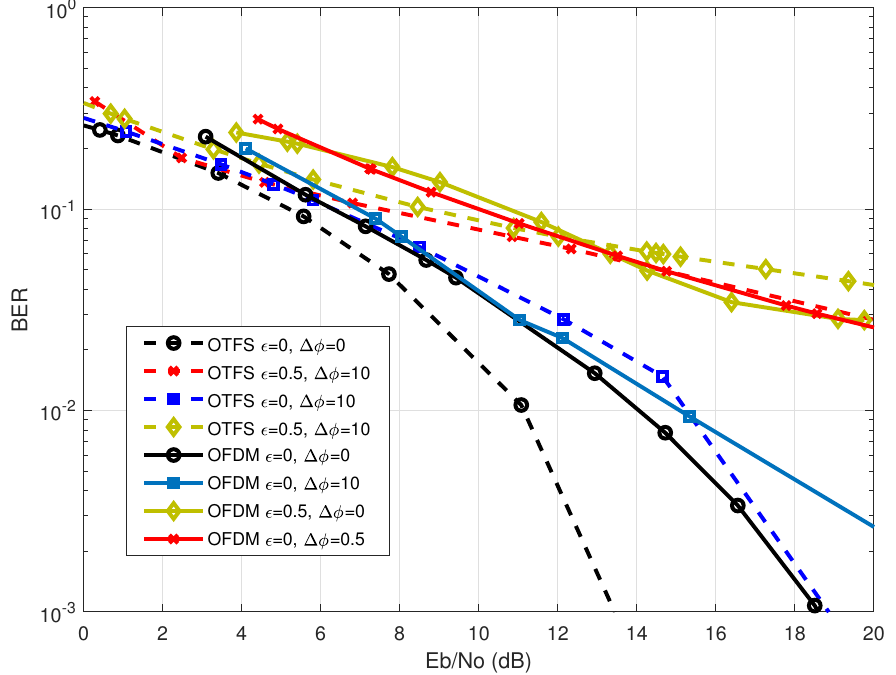
Figure 9. BER performance comparison between OTFS waveform with M = 32, N = 32 and OFDM waveform with N = 1024 considering different gains imbalance ( (cid:101) ) and phase mismatch ( ∆ φ ) I/Q imbalances at 2.4 GHz carrier